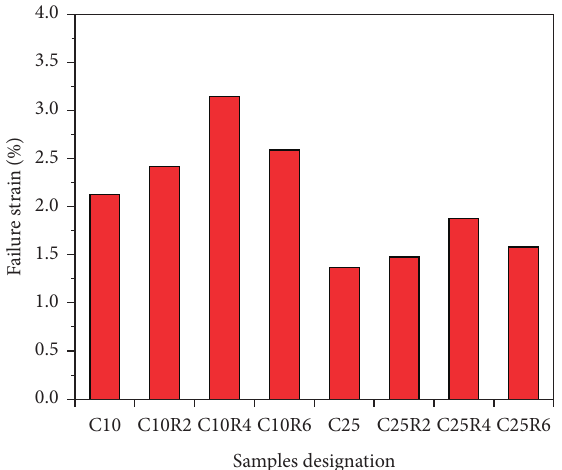
Figure 6: Failure strains of cemented tailings samples.